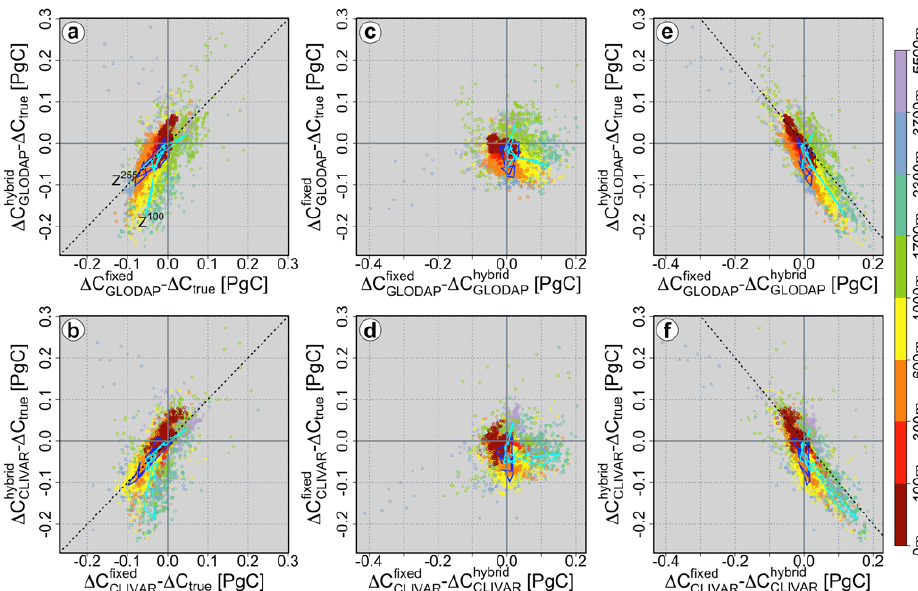
Fig. 9. Relationship between the absolute error in the layer-specific inventories obtained by the fixed-network or hybrid network cases for the (a) GLODAP and (b) CLIVAR stations. Relationships between the fixed-hybrid differences in layer-specific inventory change estimates and the absolute error between the fixed and true estimates for (c) GLODAP and (d) CLIVAR. Relationships between the fixed-hybrid differences in layer-specific inventory change estimates and the absolute error between the hybrid and true estimates for (e) GLODAP and (f) CLIVAR. The color scale identifies points from depth interval representative of the layering in Fig.